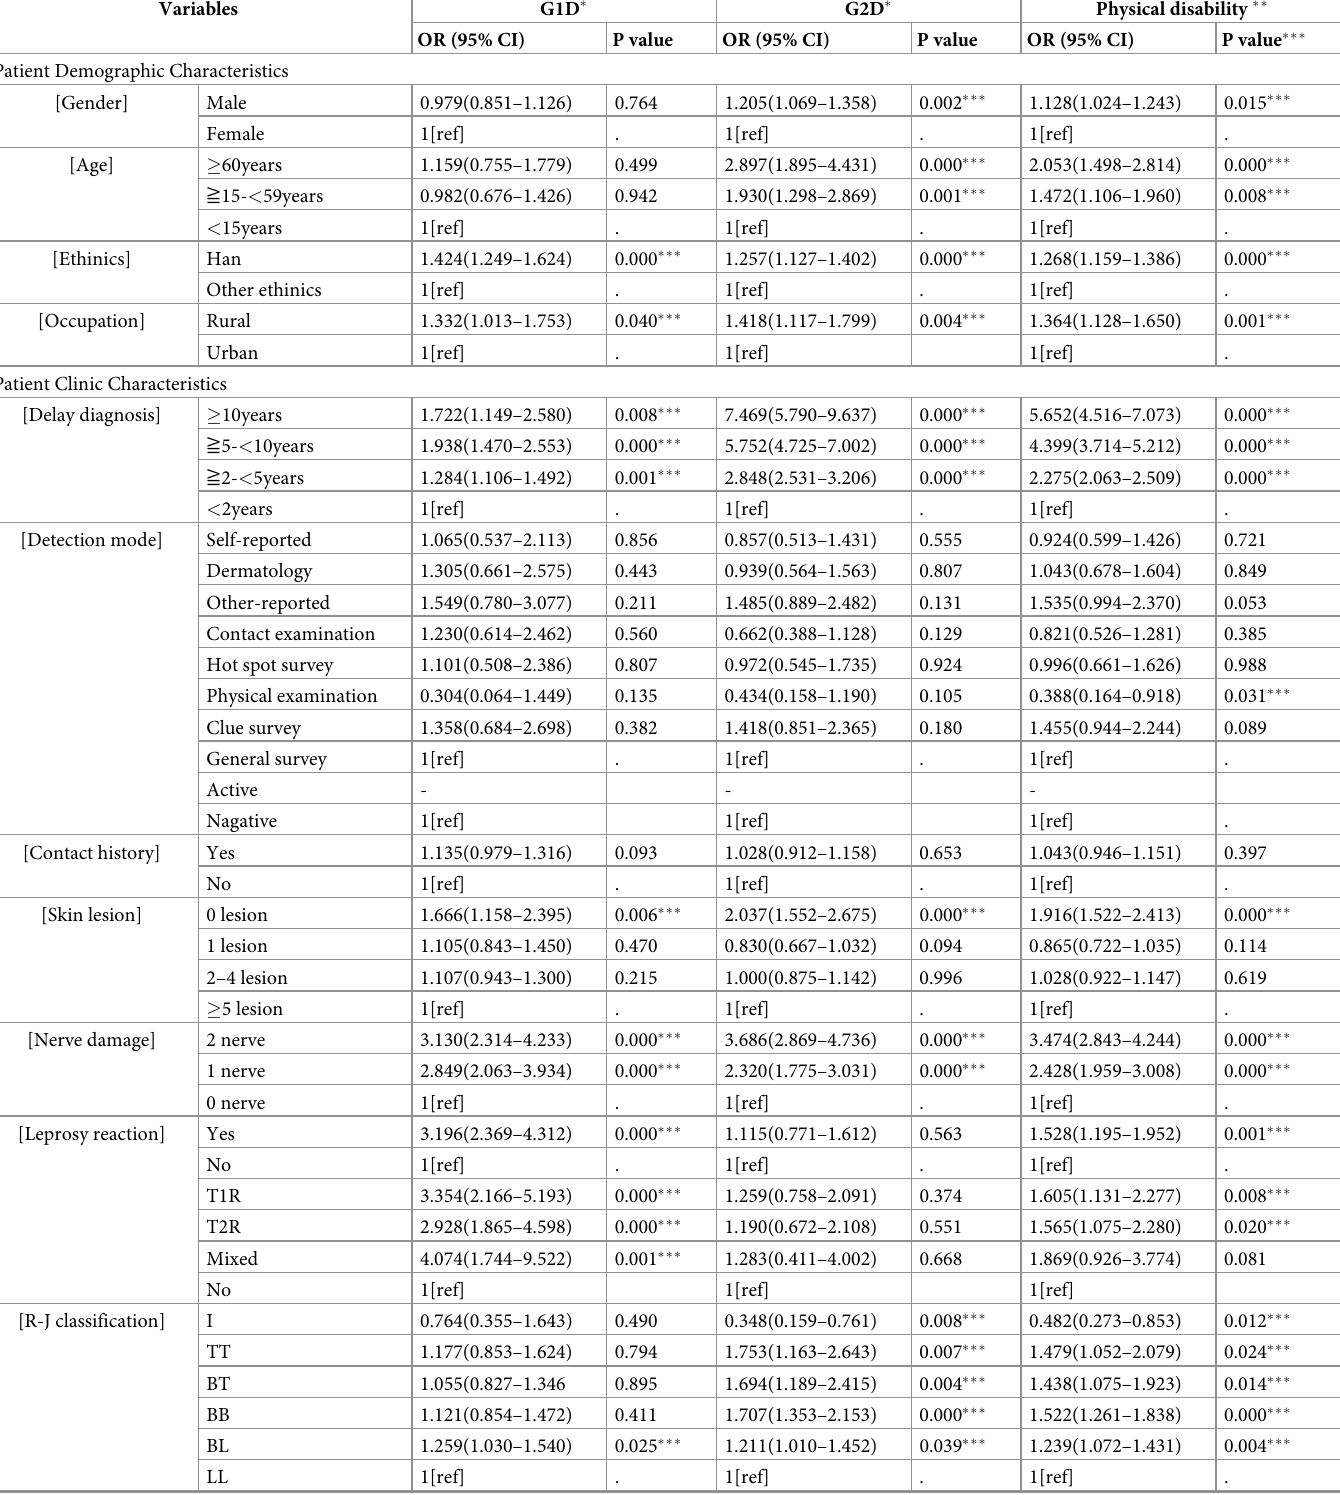
Table 2. Multinominal and ordinal logistic regression of risk factors associated with physical impairment of leprosy disease in Yunnan, China from